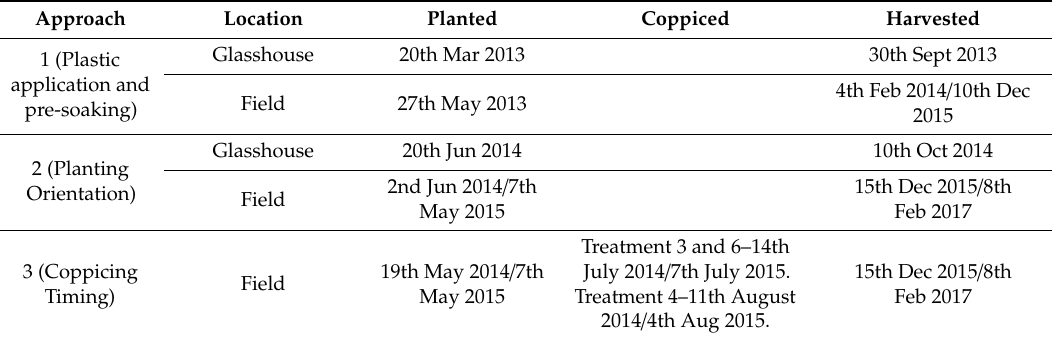
Table 2. Planting, coppicing and harvesting